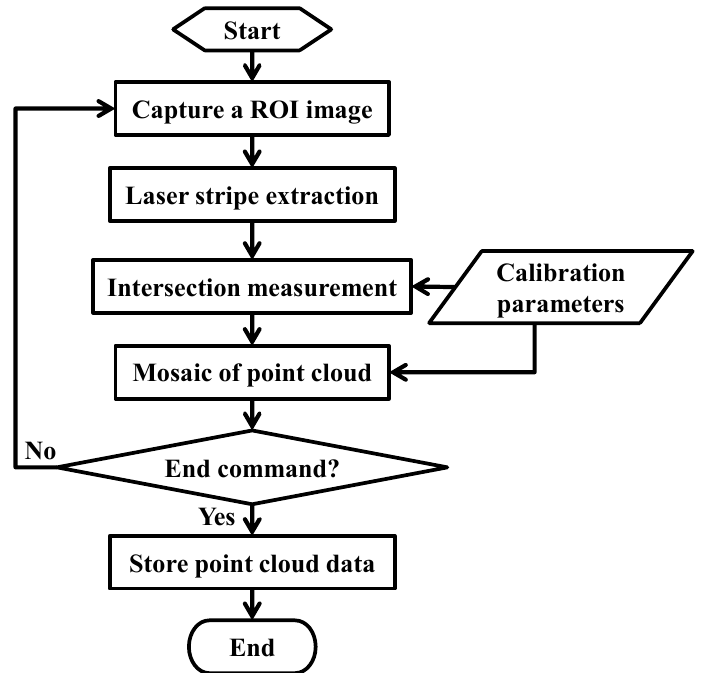
Figure 7. The flowchart of the online measurement procedure.